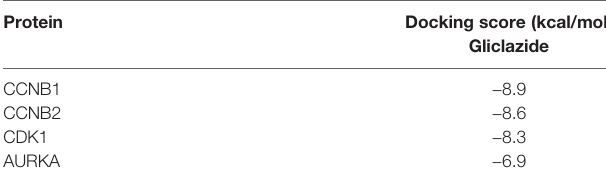
TABLE 4 | Binding energy for targets with their drugs.